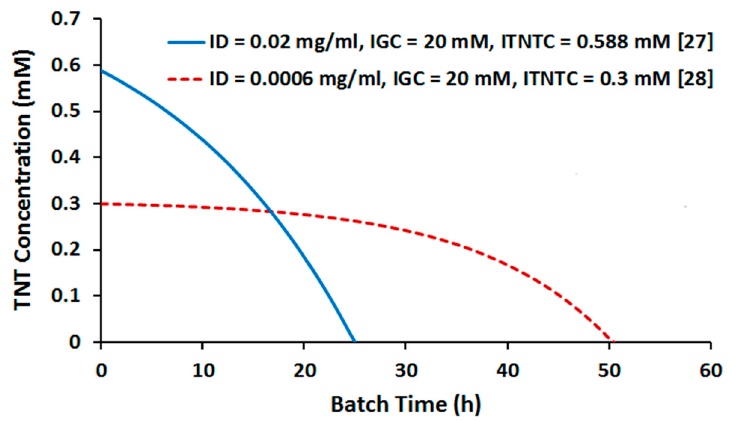
Figure 6. Batch time profile of TNT depletion as determined by dynamic flux balance analysis (DFBA) performed under experimental conditions.